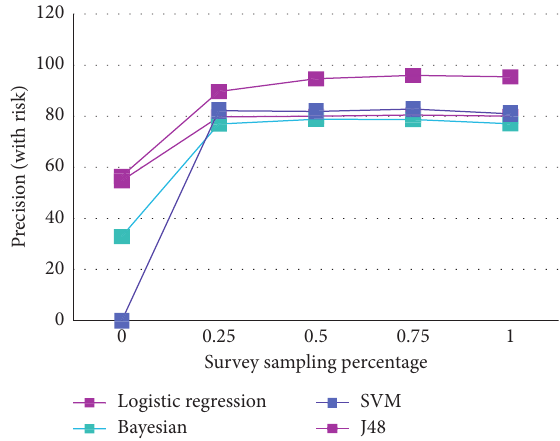
Figure 6: Comparison of accuracy (forecast with risk).